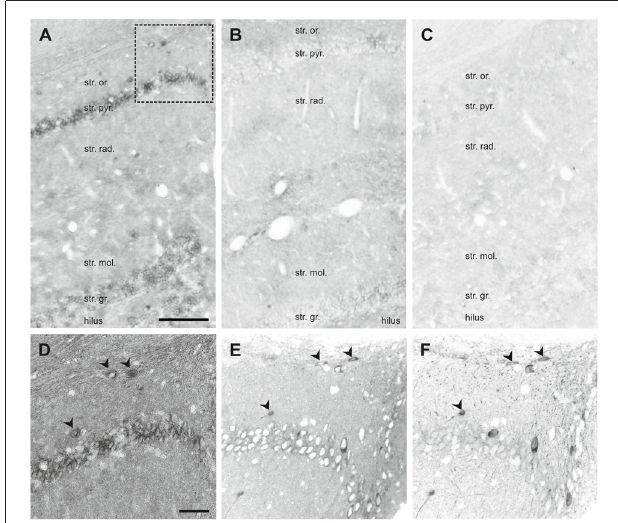
FIGURE 7 | In situ hybridization (ISH) of SNAP47 RNA in the mouse and the rat hippocampus. (A,B) Overview images ISH with anti-sense probes in mouse (A) and rat (B) hippocampus. (C) ISH image with sense probe in mouse hippocampus. (D) Higher magnification images of ISH signal in the stratum oriens, pyramidale and radiatum of the mouse CA1 area indicated by a box in (A) . (E,F) Higher magnification images of an adjacent section with double immunofluorescence labeling for SNAP47 (E) and GFP (F) shown as separate channels and inverted to grayscale. Scale bar represents 100 µ m in (A–F)